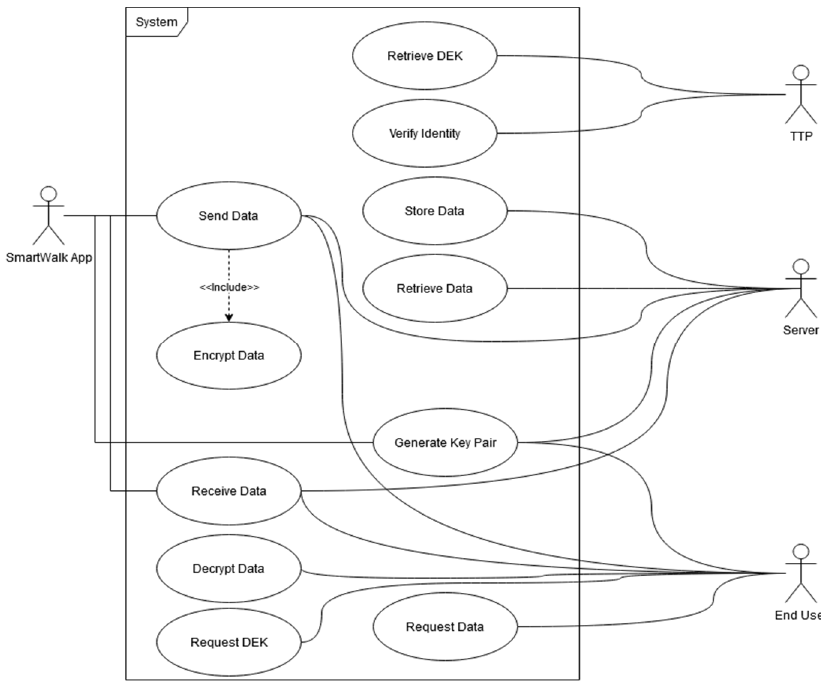
Figure 4. Security use case.